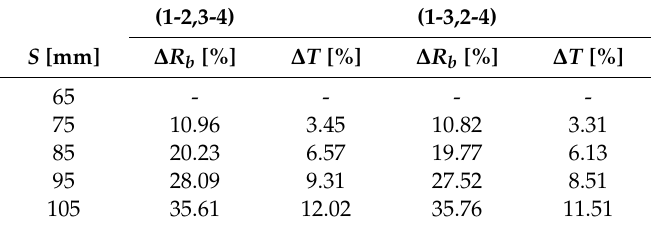
Table 6. Sensitivity of thermal resistance and outlet fluid temperature to shank spacing variation.